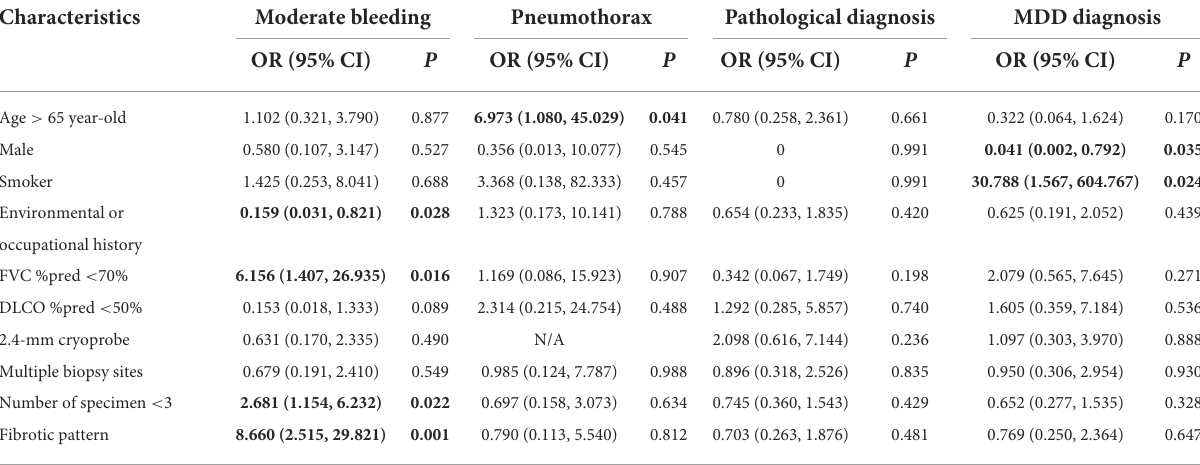
TABLE 2 Multivariate analysis for the associations between clinical characteristics and the outcomes of transbronchial cryobiopsy in ILD patients.